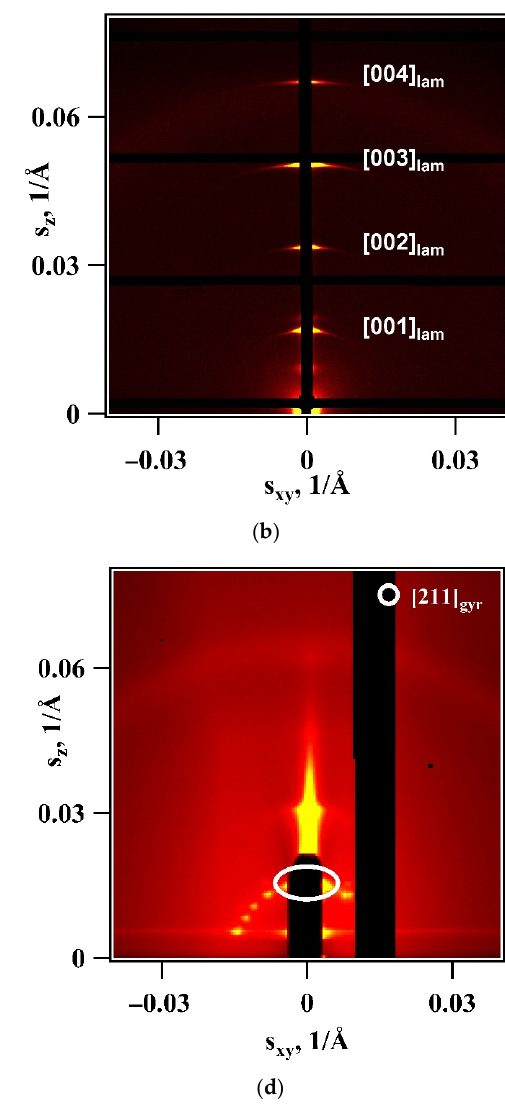
Figure 3. DSC curves: first (black) and second (red) heating traces of bulk C8AzoPyr after long annealing at room temperature.